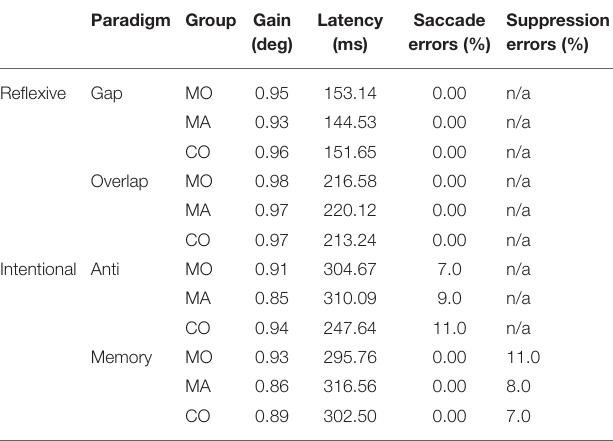
Latency Saccade Suppression (deg) (ms) errors (%) errors (%)